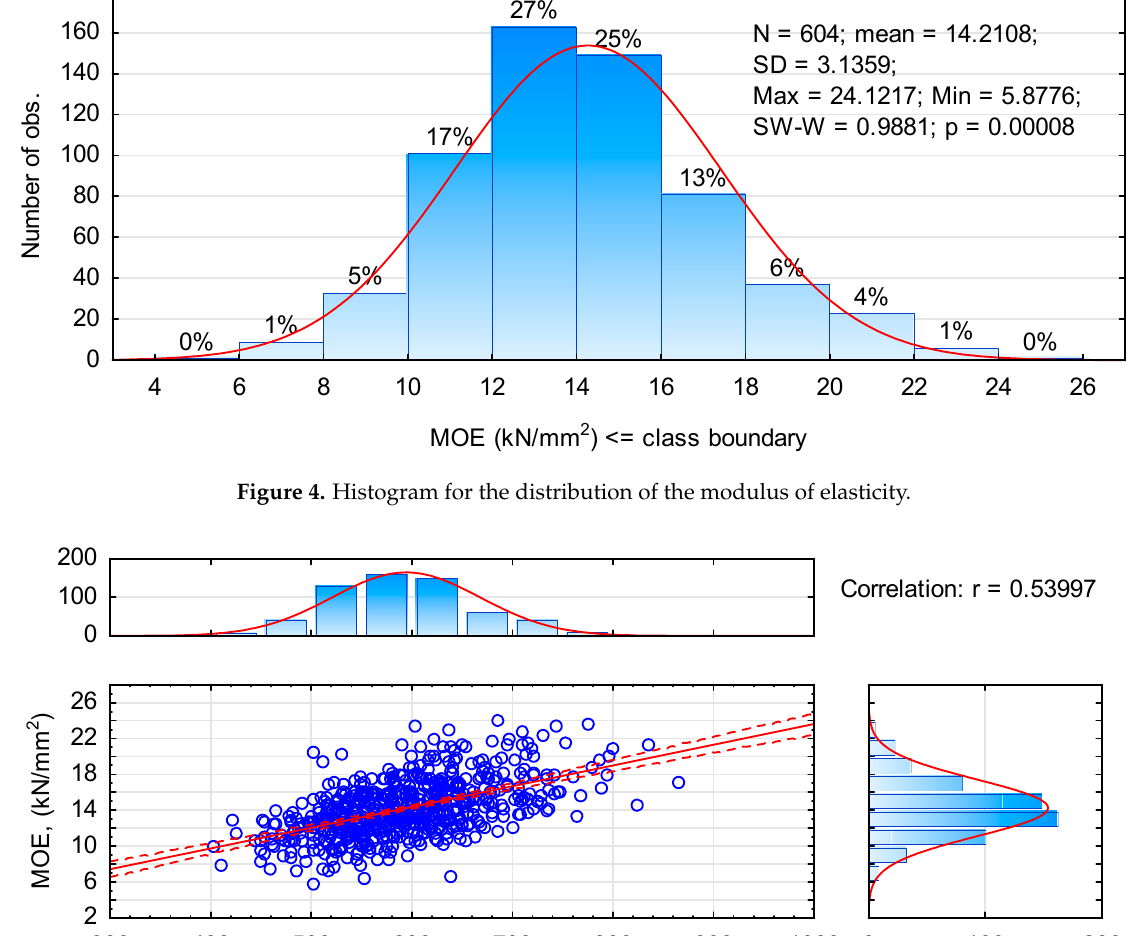
Figure 4. Histogram for the distribution of the modulus of elasticity.